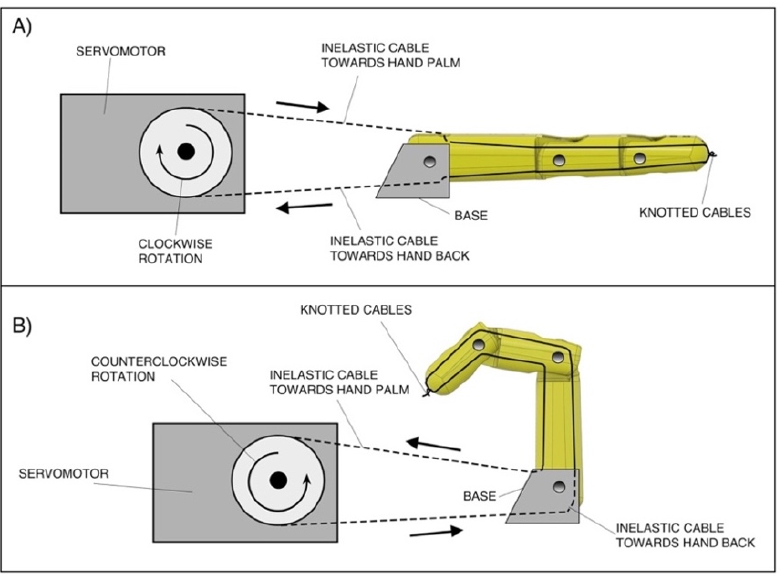
Figure 4. Finger-actuation mechanism: ( A ) finger extension by traction on the inelastic cable toward the hand back; ( B ) finger flexion by traction on the inelastic cable toward the hand palm.